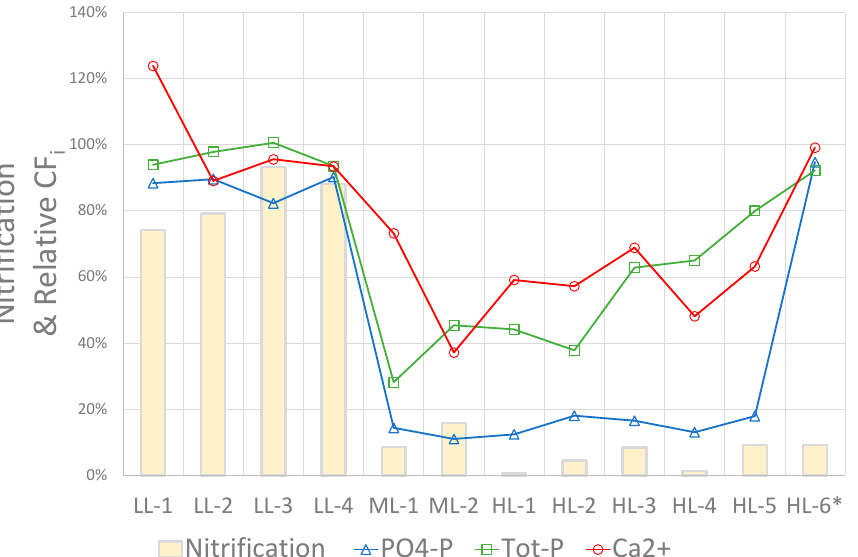
Figure 7. Concentration factors relative to the volumetric concentration factor for PO4–P, Tot–P and Ca 2+ , and nitrification (% ammonia converted to nitrate) in MBBR effluent.